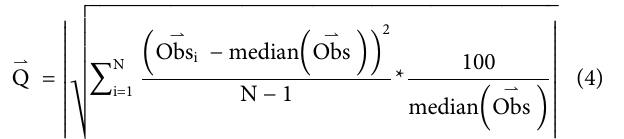
Frontiers in Earth Science |